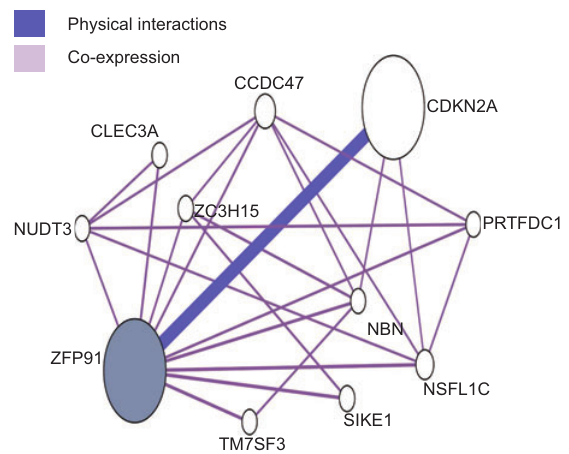
Figure 4 Functional pathway analysis of genes closely related to ZFP91 (physical interaction and